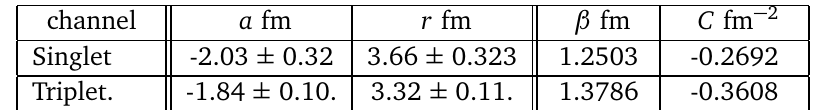
Table 2: The Λ n effective range parameters of the Nijmegen Model D [ 11 ] for the singlet and triplet channels, plus the parameters of the corresponding Yamaguchi